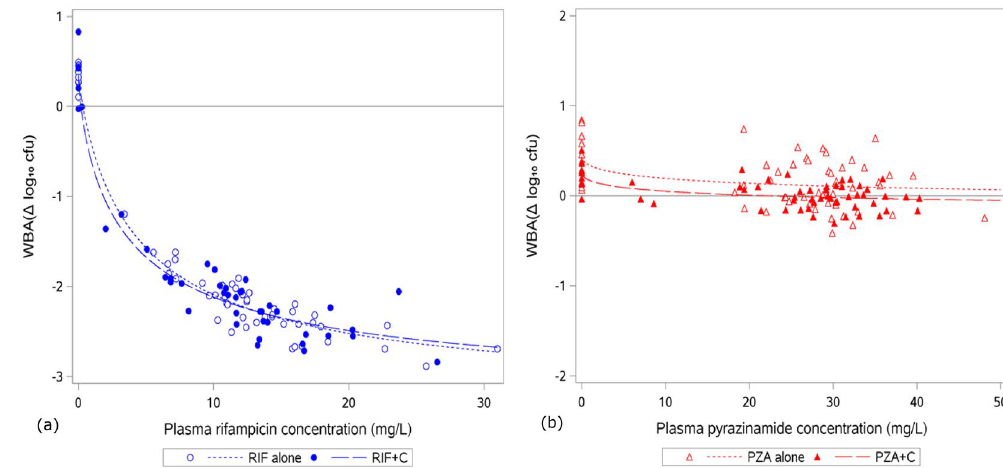
Figure 3. Relationship between plasma concentration of TB drug and WBA. Each point represents an individual blood sample at which both parameters were measured. ( a ) Rifampicin plasma concentration and WBA. The fitted model between WBA ( y ) and pyrazinamide concentration ( x ) was y